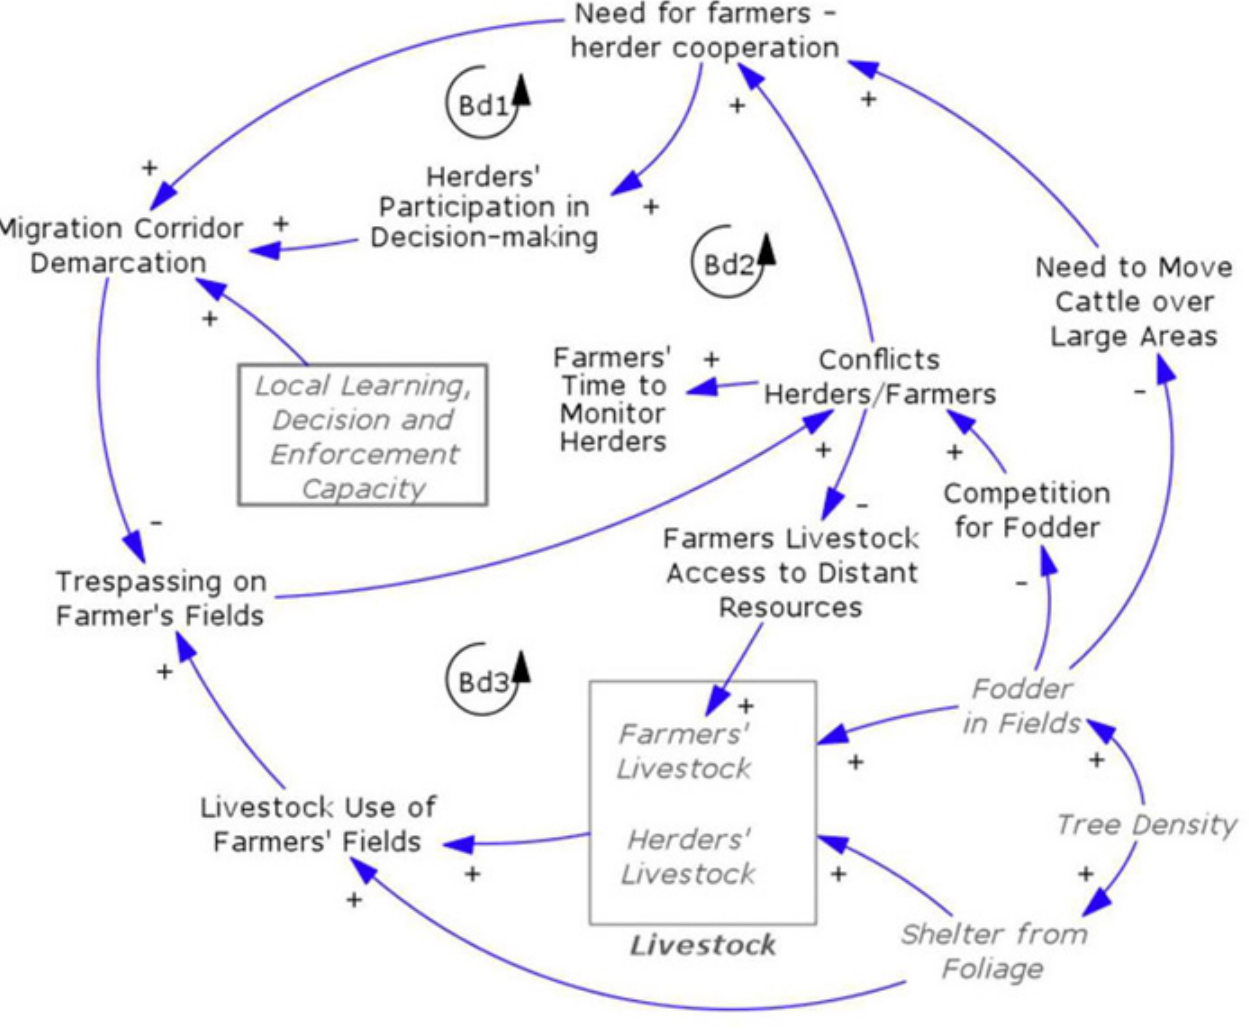
Fig. 7 . Farmer–herder relations: relations between tree and row-crop farmers and pastoralists, modeled at local-to-regional